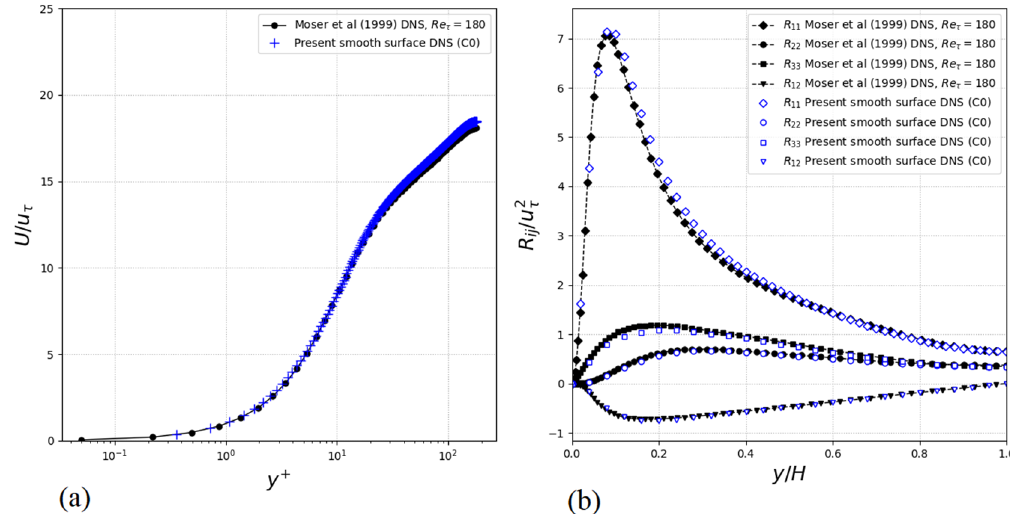
Figure 6. Comparison of the ( a ) near-wall velocity profiles and ( b ) Reynolds stress profiles between the present smooth wall simulation results and DNS results by Moser et al. [16].